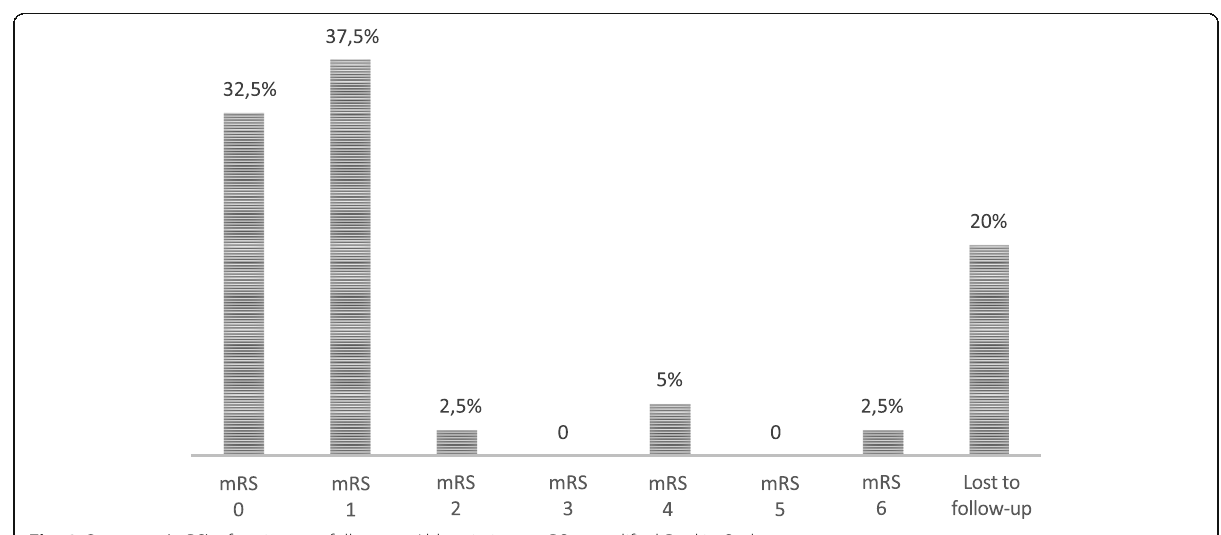
Fig. 3 Outcome (mRS) of patients at follow-up. Abbreviations: mRS = modified Rankin